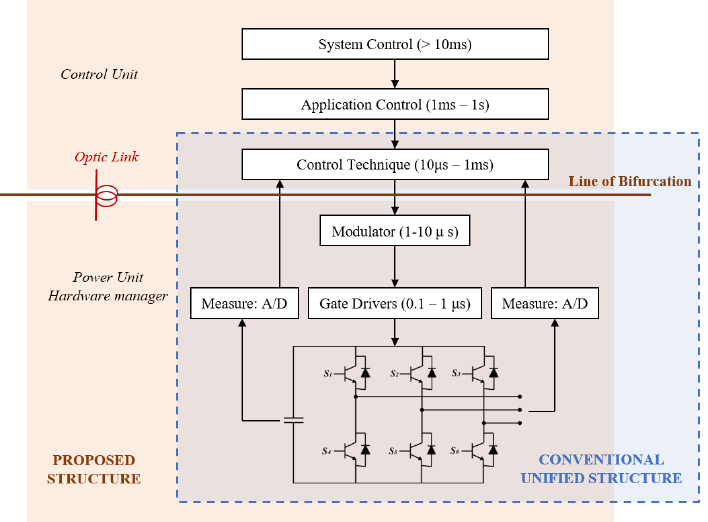
Figure 1. Common control layers for a Power Electronic Converter (PEC). Conventional and proposed solutions are